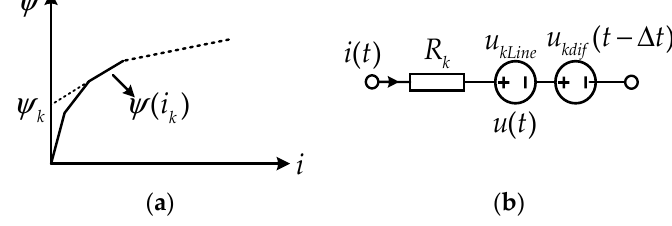
Figure 3. Piecewise linear representation of the nonlinear inductor and its equivalent circuit: ( a ) piecewise linearization; ( b ) equivalent circuit.